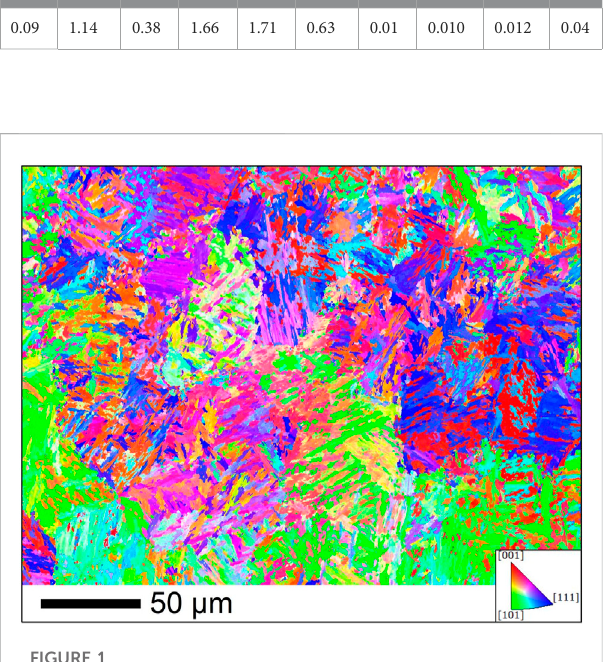
FIGURE 1 Microstructure of the as-received weld in terms of an inverse pole fi gure map (IPF-Z) obtained by